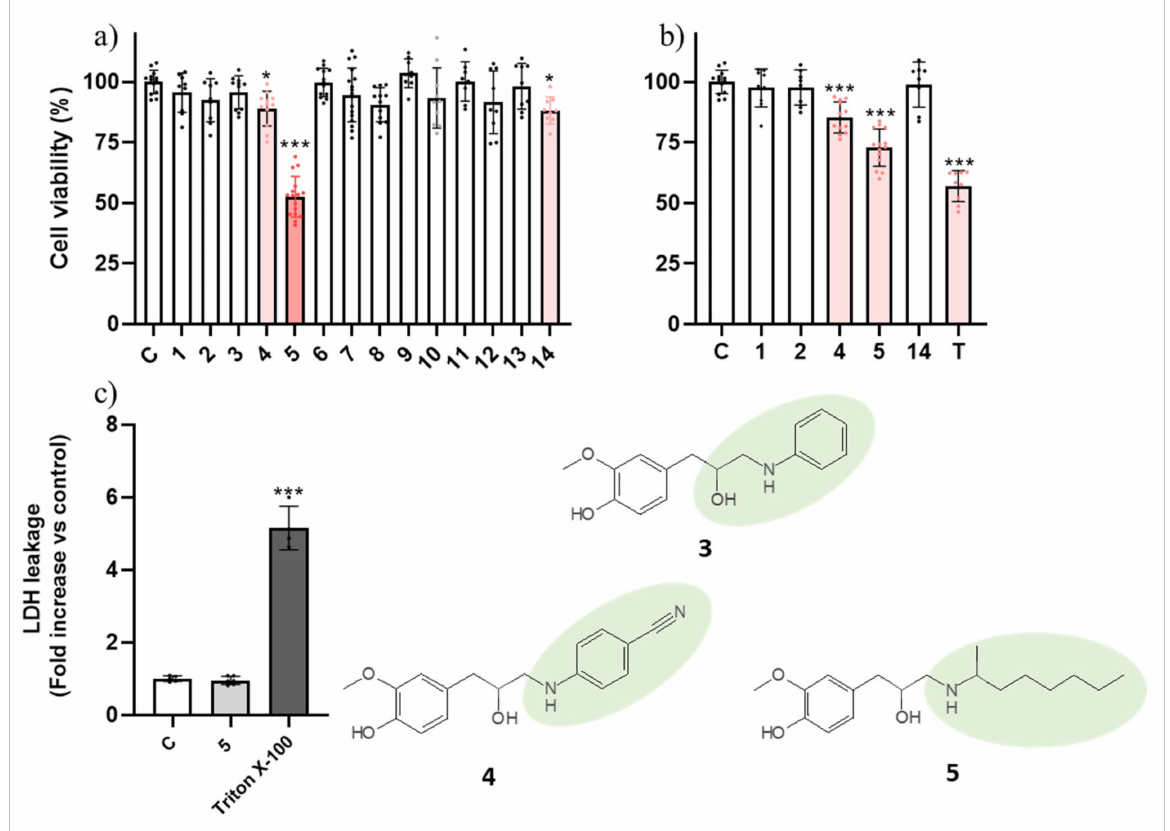
Figure 1. Viability of AGS cells exposed to the molecules at 200 µ M ( a ) and 100 µ M ( b ). The effect of topotecan at 5 µ M is also presented in ( b ) for benchmark purposes. ( c ) Influence of molecule 5 (100 µ M) on membrane integrity of AGS cells after 24 h. Triton X-100 at 1% was used as a positive control for maximum extracellular LDH activity. Each dot represents a single determination. C: control; T: topotecan. * p < 0.05; *** p <